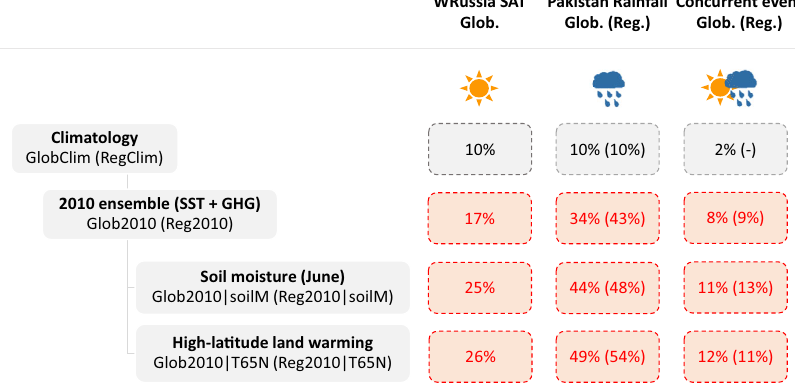
Fig. 3 Schematic of 2010 extremes probabilities derived from W@H. First row: the probability of exceeding the 90th percentile threshold for WRussia SAT and Pakistan Rainfall Indices and probability of exceeding both the 90th thresholds for both WRussia SAT and Pakistan Rainfall contemporaneously in GlobClim. 10% probabilities in the climatology row of the WRussia SAT and Pakistan Rainfall columns are true by construction. Pakistan Rainfall is available for both global and regional model runs but WRussia SAT is available only for global simulations as the Regional model is centered over South Asia. Concurrent events probability cannot be carried out for RegClim since this ensemble of simulation is not nested on the analyzed GlobClim ensemble. Second row: Same as the fi rst row but for Glob2010 (SAT and Rainfall) and Reg2010 (Rainfall). Third row: Same as the fi rst row but for a sub-selection of ensemble members in Glob2010 (SAT and Rainfall) and Reg2010 (Rainfall) showing dry soil conditions over western Russia in June. Fourth row: Same as the fi rst row but for a sub-selection of ensemble members in Glob2010 (SAT and Rainfall) and Reg2010 (Rainfall) showing high-latitude land warming signal in the 24.07 – 08.08